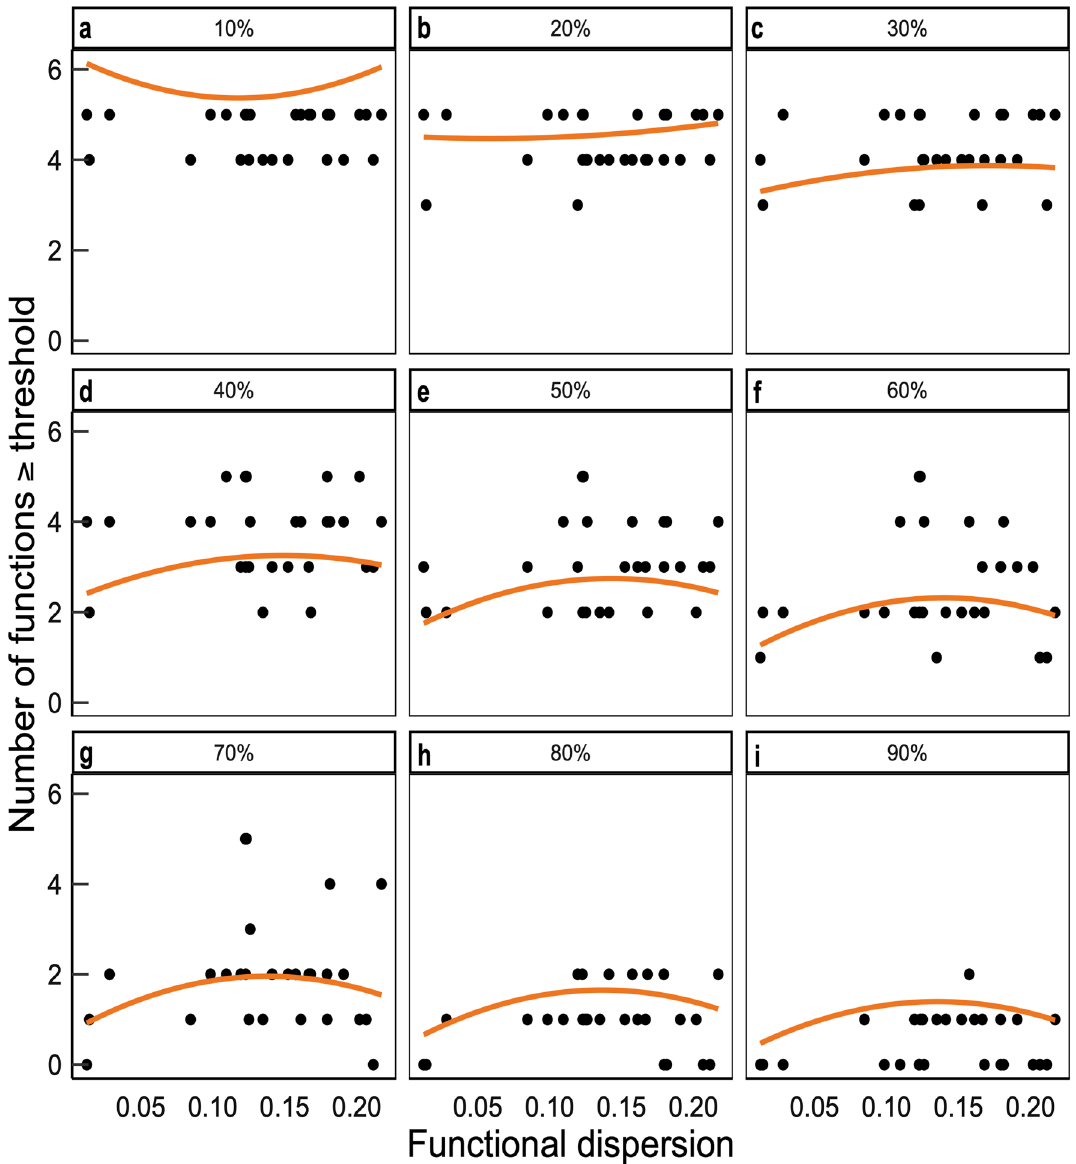
Figure 4. Partial regression plots showing the relationship between the functional dispersion of plant communities (based on traits involved in plant–parasitoid interactions) and the multi-species parasitism of five herbivorous crop pests, measured at a distance of 5 m from the flower strips. Multi-species parasitism, quantified with a multi-threshold approach, is the number of herbivore species for which the rate of parasitism exceeds a given percentage (thresholds from 10 to 90%) of the maximum parasitism achieved for each species. This figure was made using R version 3.6.3 30 (https:// www.R- proje ct. nutrient reserves to ensure that they have little or no need to find food 35 , (2) the parasitoids of this species may rely on other hosts in the flower strips, on other trophic resources, such as pollen or honeydew, or may rely on host feeding 36 , (3) the parasitoids may have fed on oilseed rape flowers, which could have provided a massive amount of nectar resources in April and May, (4) other traits may have prevented the use of nectar or (5) a patchy distribution of the host population may have masked the effect of the different flower strips. In our estimation of nectar resources, we took into account (1) the temporal match between periods of nectar production and insect flight activity and (2) morphological constraints on the size of the insect head and mouthparts imposed by flower shape. These topological traits sensu Gravel et al. 37 determine the occurrence of trophic interactions. The intensity of these interactions also depends on traits relating to flower attractiveness or the nutritional characteristics of the nectar 6 , which were not taken into account here. Parasitoid preferences for particular flower resources and the effects of these resources on insect fitness can be determined 38 , but the traits underlying these interactions are not straightforward to identify or easy to measure. These interactions may be highly specific, and a trait-based approach is not necessarily more straightforward than a species-based approach.